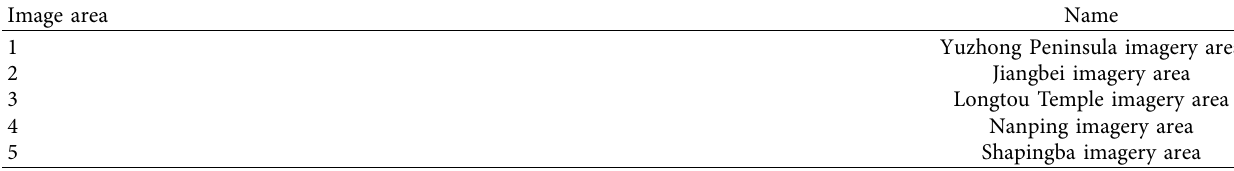
Table 1: Image area.